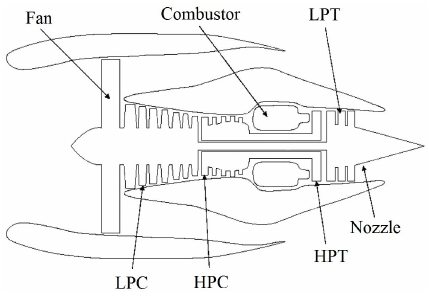
Figure 1. Diagram for the aircraft gas turbine engine [33].